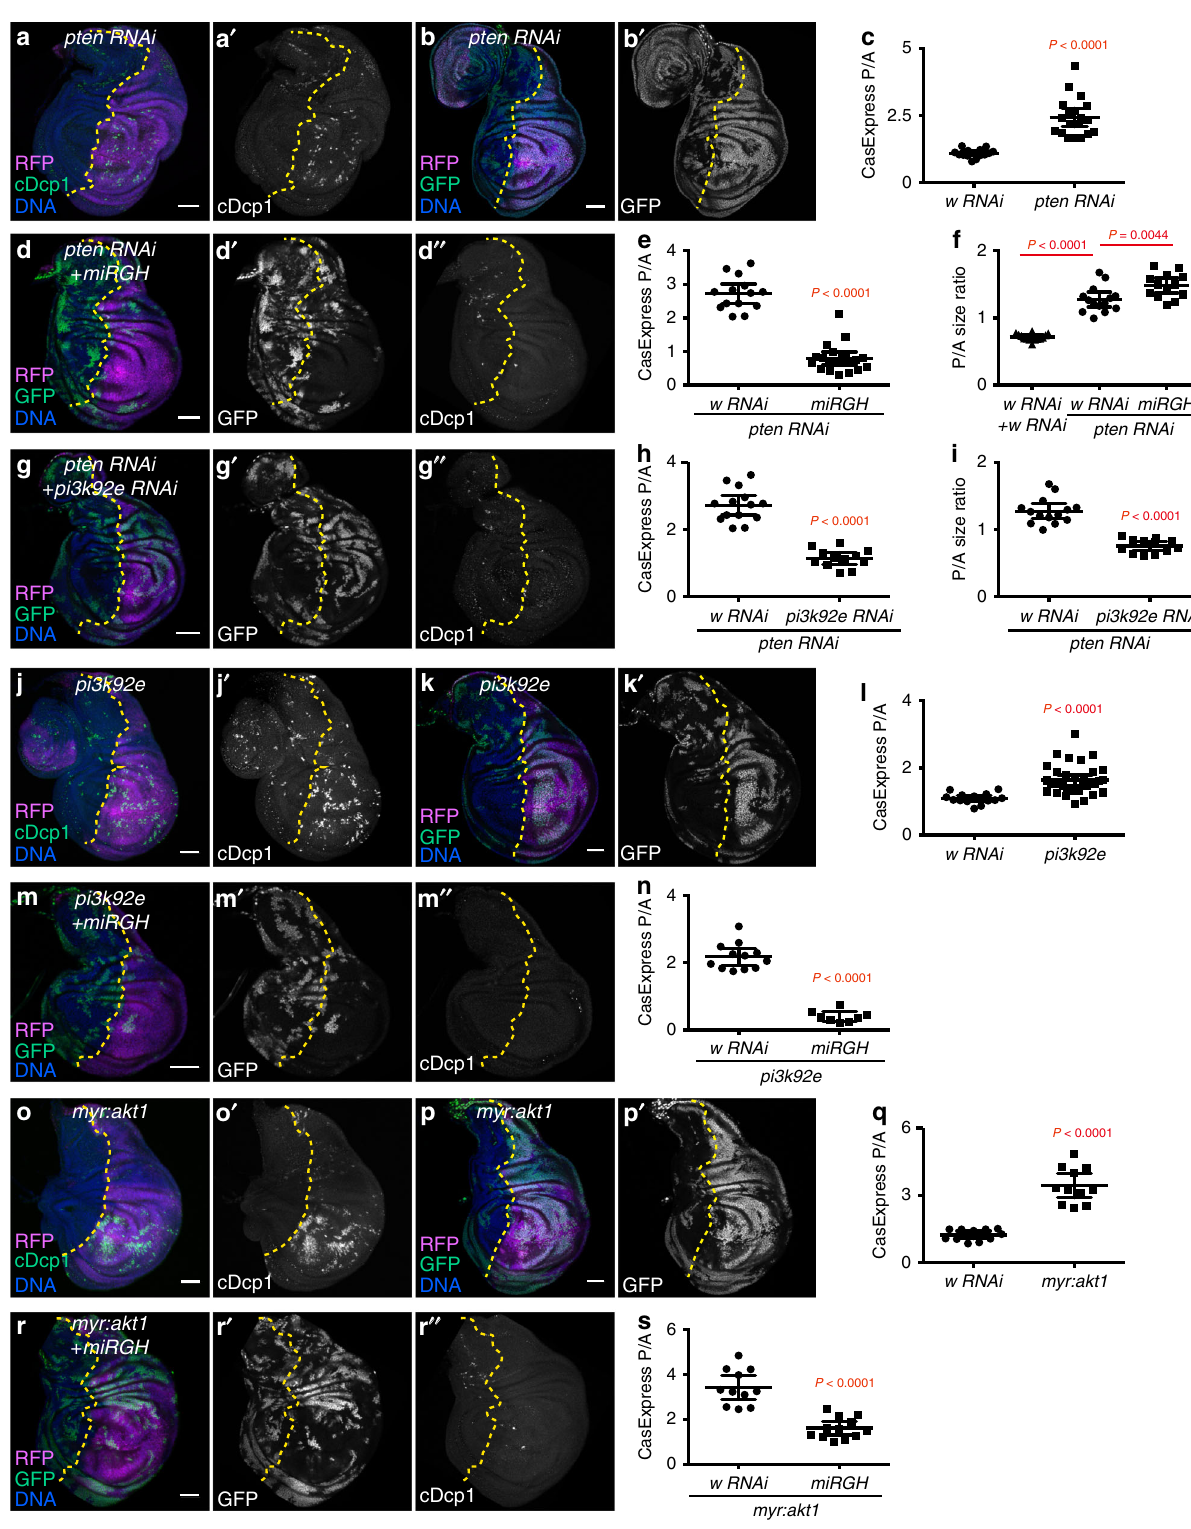
Akt1 and dCIZ1 promote survival of cells with oncogenic Ras V12 -induced executioner caspase activation . Hyperactivation cers. The human PIK3CA gene, which encodes the